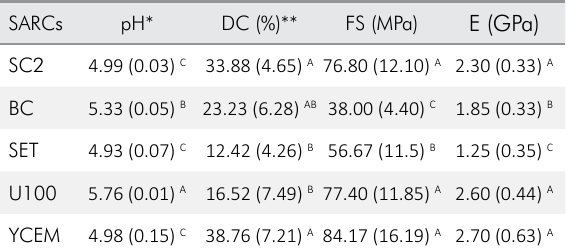
Table 3. Means (standard deviations) for the physic-chemicals properties tested.